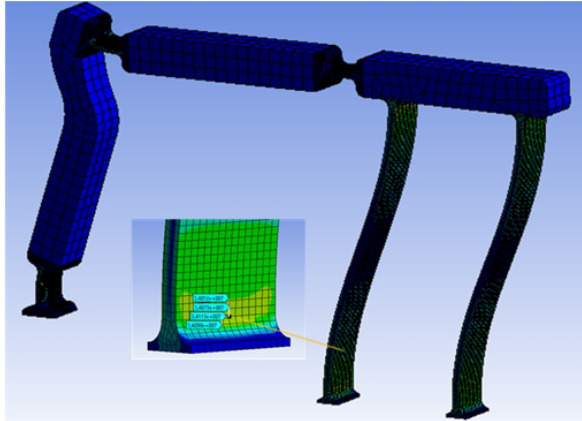
Figure 13. Theoretical and experimental stroke and axis drift of the fully compliant slider-crank